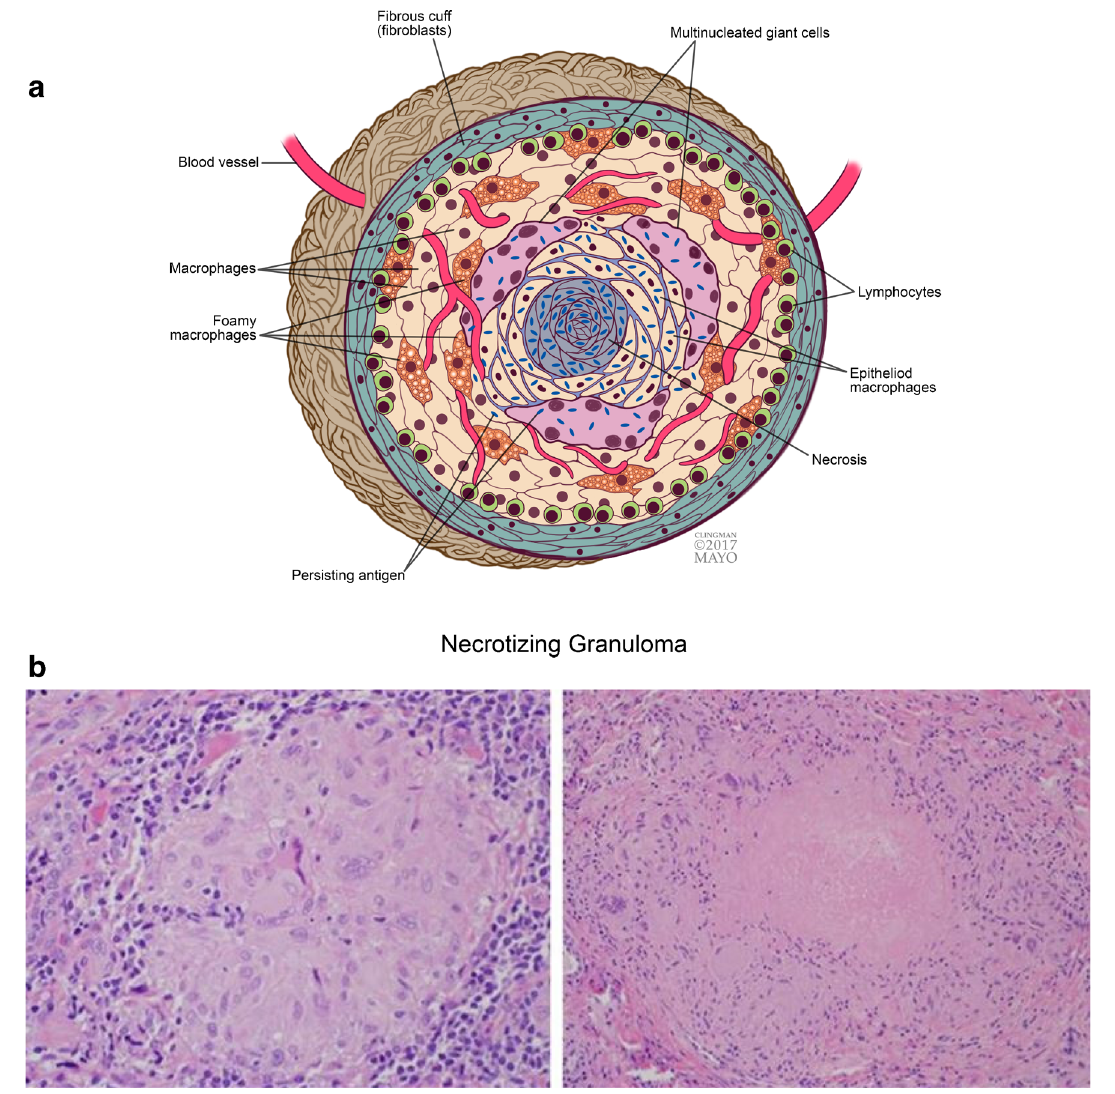
(original magnification x20, hematoxylin-eosin) of a nonnecrotizing granuloma (left) composed of lymphocytes, macrophages, and giant cells and a necrotizing granuloma (right) with central necrosis